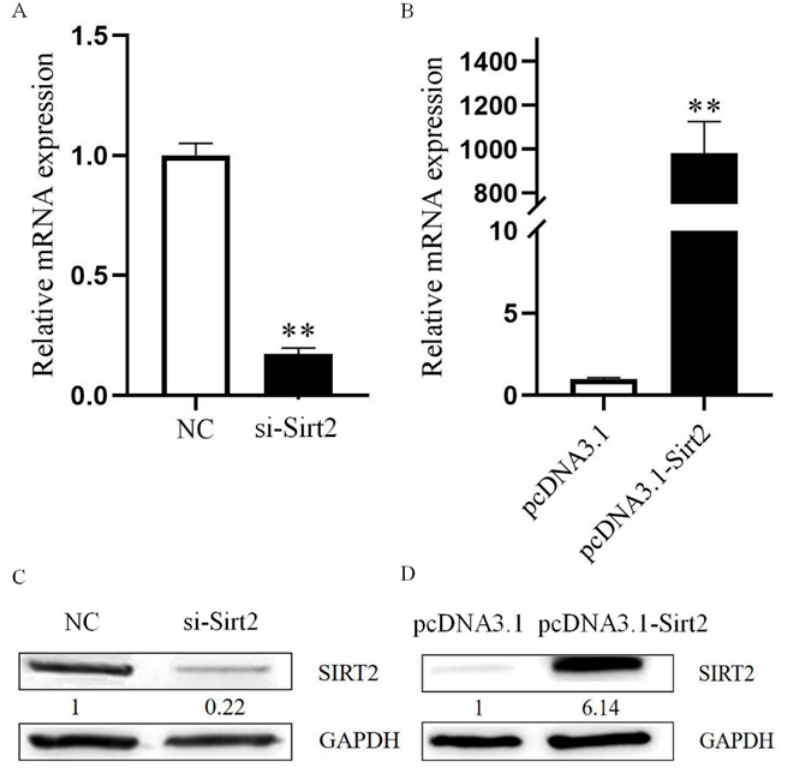
Figure 3. Determination of Sirt2 knockdown and overexpression efficiency in present study. ( A ) Detection of mRNA level of Sirt2 by qRT-PCR after siRNA knockdown. ( B ) Detection of mRNA level of Sirt2 by qRT-PCR after overexpression. ( C ) Detection of protein level of SIRT2 by Western blot after siRNA knockdown. ( D ) Detection of protein level of SIRT2 by Western blot after overexpression. **, significant difference ( p < 0.01). The results were obtained in three independent exper- iments.